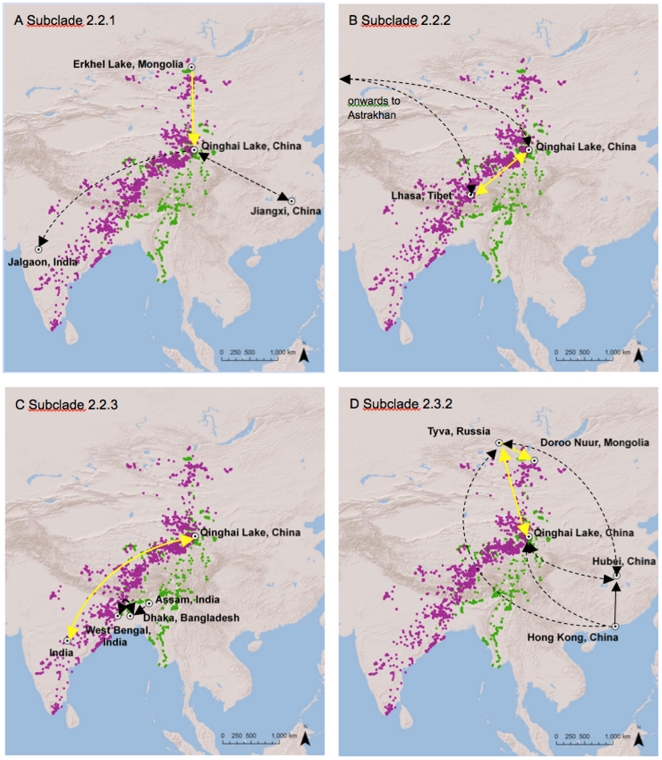
Phylogeographic relationships of HPAI H5N1 in relation to bar-headed geese (purple) and ruddy shelduck (green) in the Central Asian Flyway, 2005–2010.Four subclades characterized the evolution of HPAI H5N1 in wild birds and poultry during this period (a) 2.2.1, (b) 2.2.2, (c) 2.2.3 and (d) 2.3.2. The hypothesized mode of virus movement includes; wild birds (yellow), poultry (black) or inconclusive (dashed).